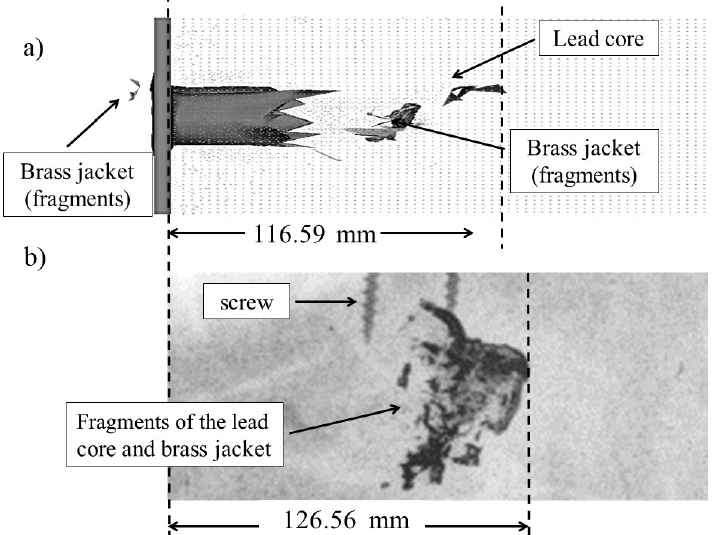
Figure 7. Comparison of fragmentation and penetration depths of the 7.62 mm FMJ bullet in the FSF block from ( a ) numerical simulation and ( b ) X-ray photography.